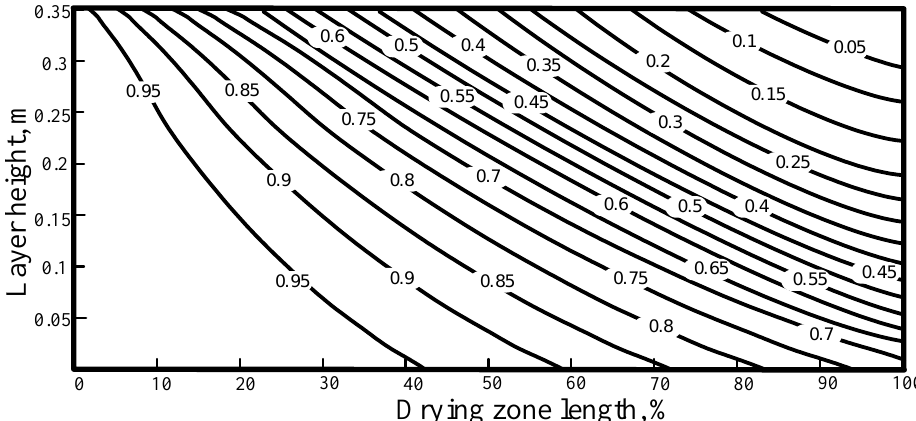
Figure 12. Parametric family of isolines showing the variable ψ -relative degree of pellets drying.